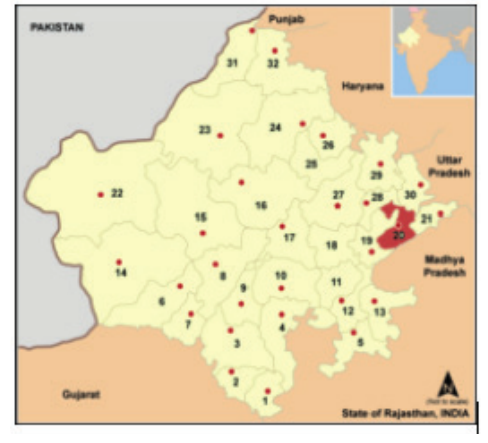
Figure 1. ‘Karauli District’, Rajasthan Figure 2. Miners at work without any PPEs during working in Rajasthan,